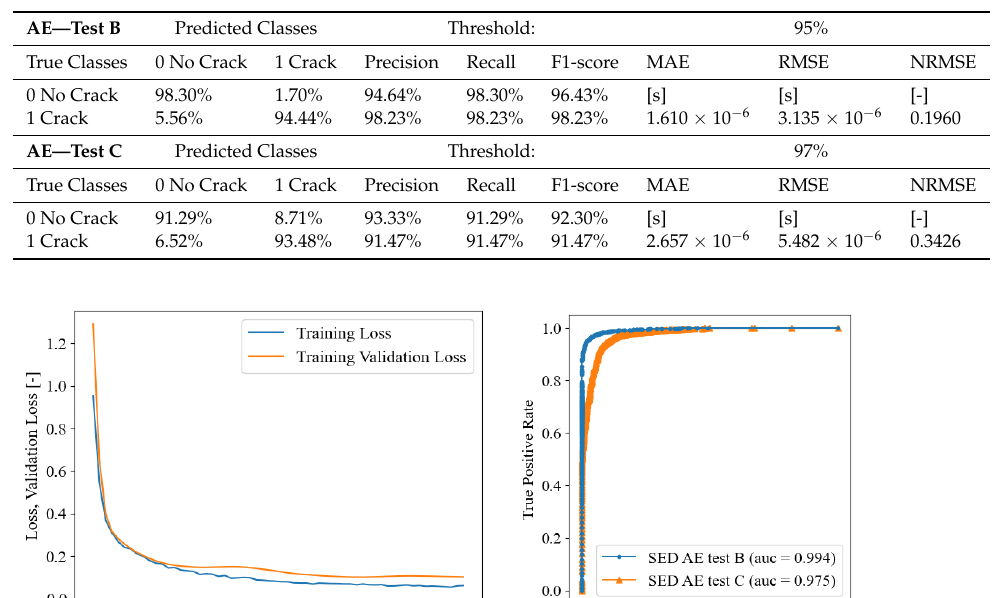
Table 5. Confusion matrix and classification metrics for fine-tuned SED, tested on the AE datasets (100 signals for 3 setups A, B, and C).